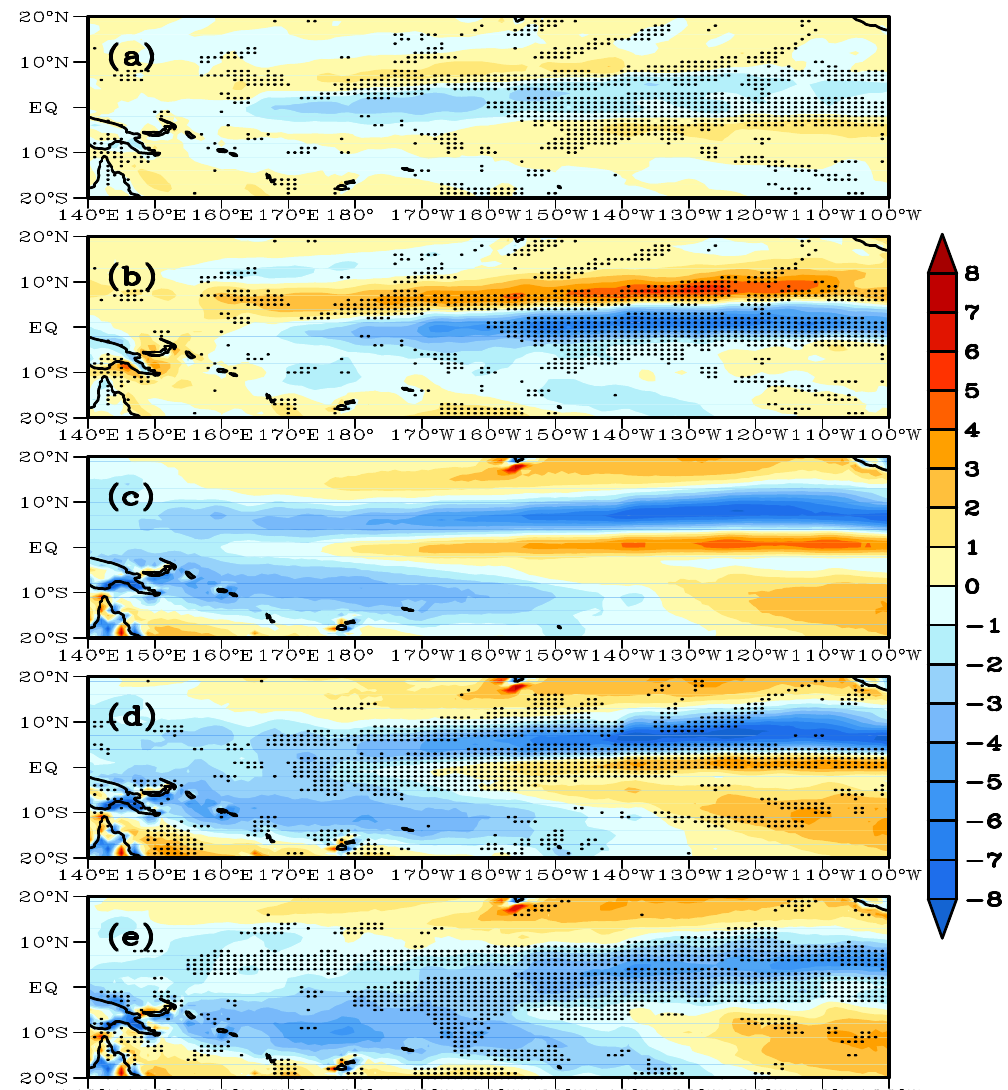
Figure 4. Low-level atmospheric divergence anomalies ( a is CP-El Niño, b is EP-El Niño) in two types of El Niño years, and the comparison of the divergence field in ordinary years ( c ) and two types of El Niño years ( d is CP-El Niño, e is EP-El Niño), unit: 10 −5 s −1 . The dots passed the 95% significance test, where ( a ) and ( b ) show the significant difference in divergence between two types of El Niño years, and ( d )/( e ) shows the significant difference in divergence between ordinary years and CP-El/EP-El Niño years.